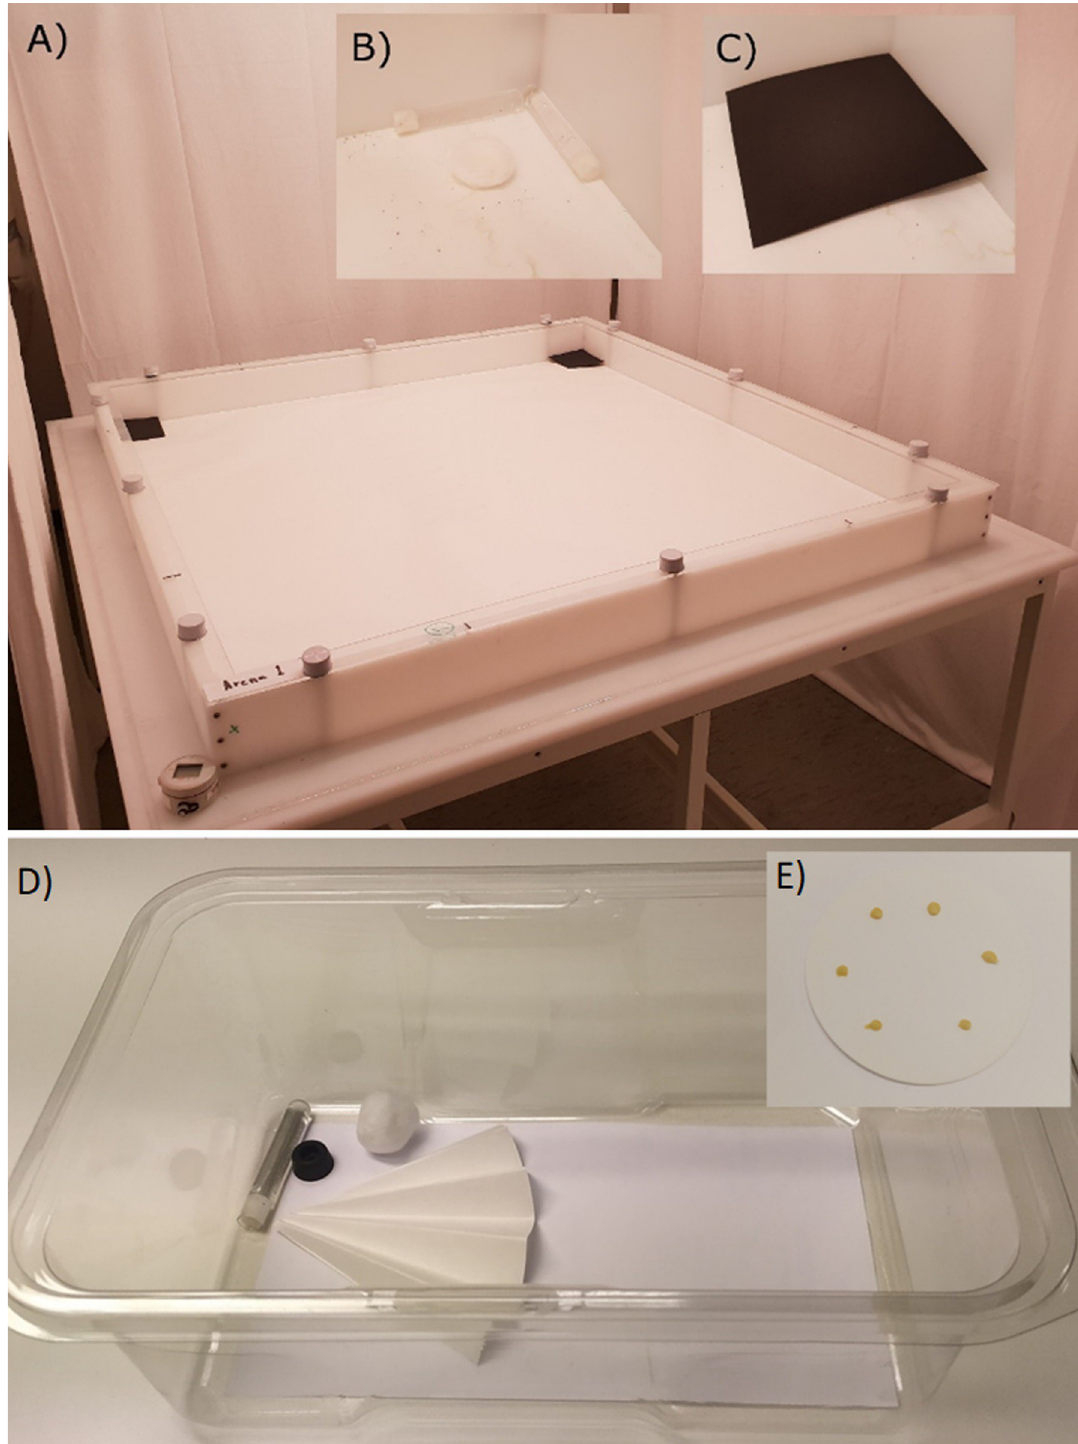
Fig 1. Bioassays used to test bait against Ctenolepisma longicaudatum . (A) An overview of the arena with an inner experimental area of 126 cm × 126 cm used to test spatial elements of bait placement, (B) water tubes and cotton ball in harbourages and (C) harbourage with black lid in place. (D) Population boxes used to investigate temporal elements of bait placement and sanitation. (E) Filter paper with six droplets of Advion 1 Cockroach Gel bait that were placed in the population boxes for test of temporal elements of bait